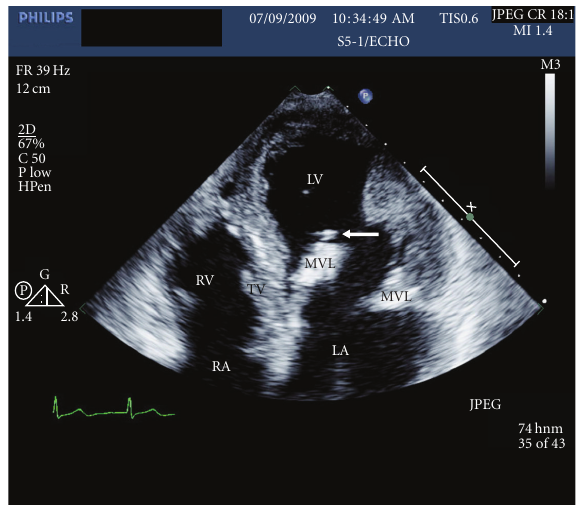
Figure 2: Four chamber view echocardiogram showing large vegetation on the MVL marked by arrow. LV-left ventricle, LA- left atrium, RV-right ventricle, RA-right atrium, TV-tricuspid valve, MVL-mitral valve